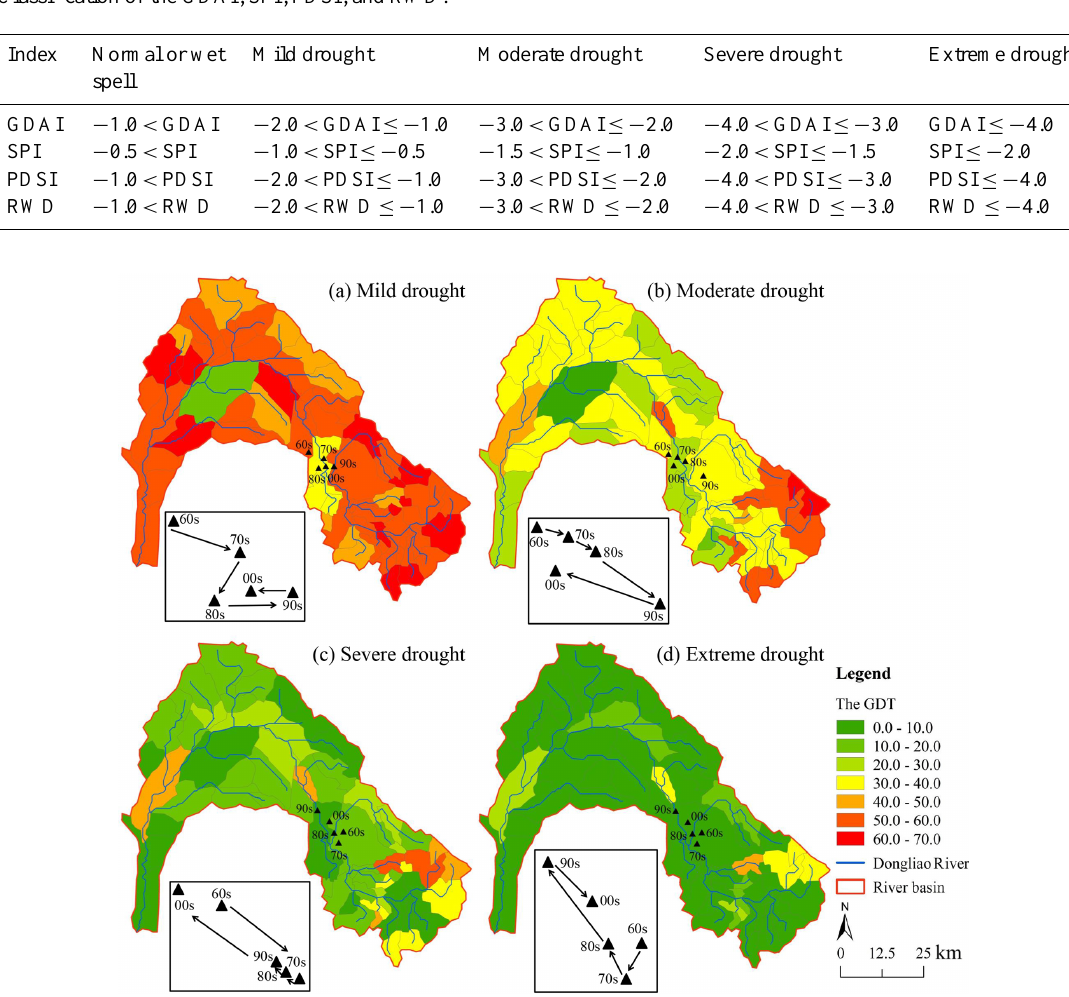
Figure 4. Spatial distribution of the GDT of different drought levels in various